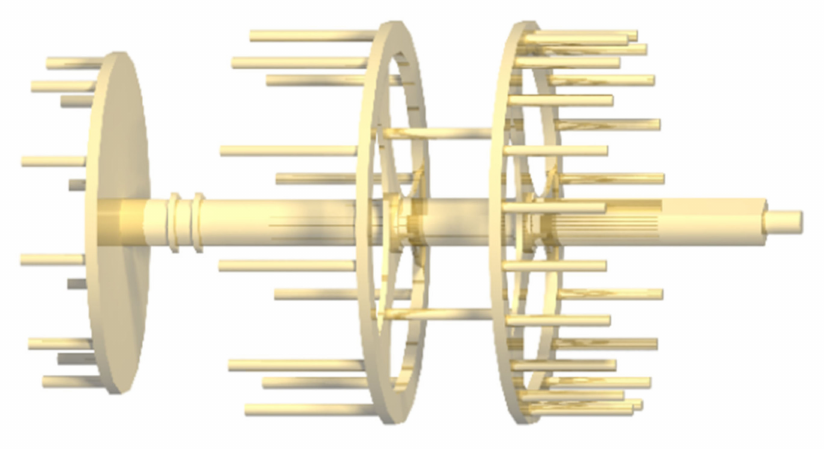
Figure 8. Intermediate sub-assembly or